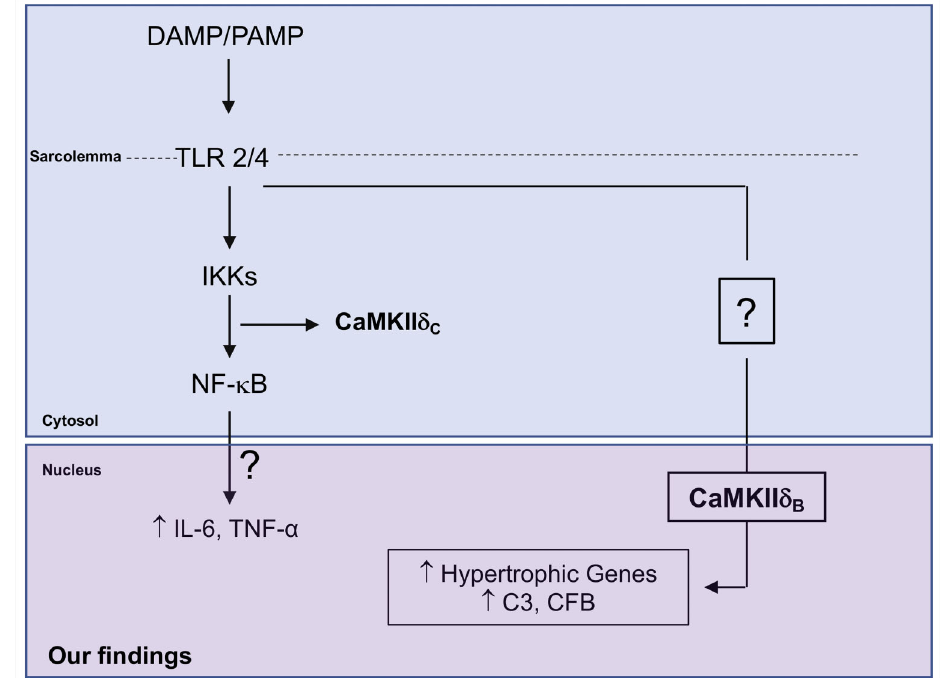
Figure 5. Schematic representation of the study showing the pathways and mechanisms highlighted and their interactions in order to prevent cardiac hypertrophy. DAMP/PAMP: damage-associated molecular patterns/pathogen-associated molecular patterns; TLR: Toll- like receptor; IKK: IKK kinase complex; CaMKII d B: Ca 2 + /calmodulin-dependent kinase II delta B; NF- k B: nuclear factor-kappa B; IL: interleukin; TNF- a : tumor necrosis factor alpha; C3: complement 3; CFB: complement factor